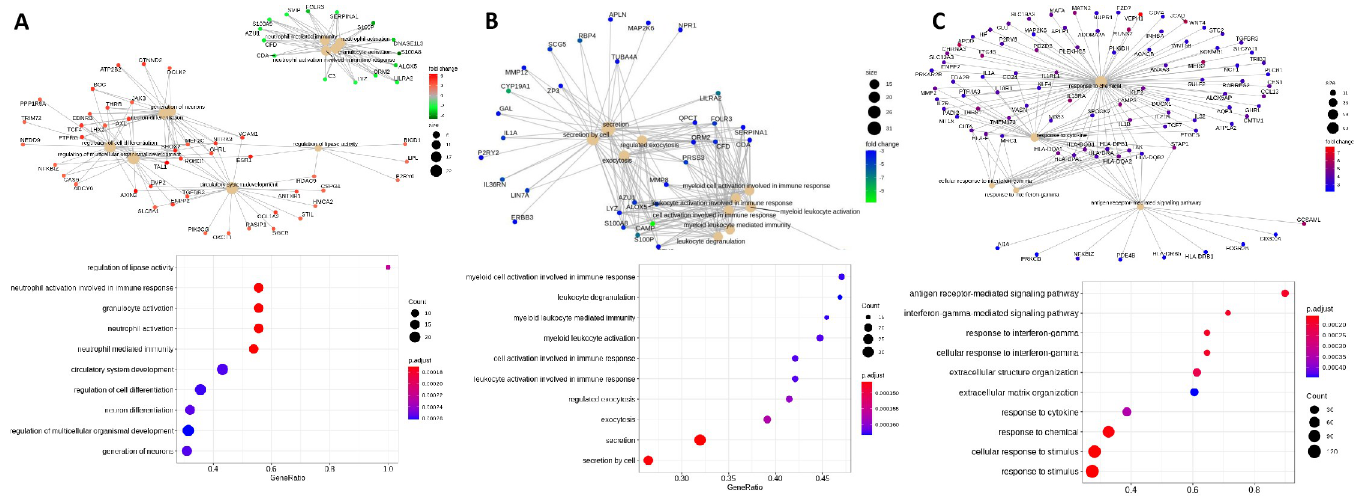
Fig 9. Functional enrichment analysis visualization. Gene concept network plots (cnet plots) and dot plots showing the results of GO (biological process) term enrichment analysis performed for all the statistically significant (corrected p-value � 0.05 and |Log2FC| � 2) upregulated and downregulated genes obtained from RNASeq analysis of the SNCA A53T macrophage (A), GRN R493X macrophage (B), and MECP2 HM macrophage (C) relative to 01279 parental macrophage. Dot size indicates k/n ratio (“gene ratio”), where k is the number of genes participating in the current GO biological process (within the selected gene list), and n is the total number of genes annotated as participants of any GO term. Dot color indicates the enrichment test p-value (Fisher’s exact test).